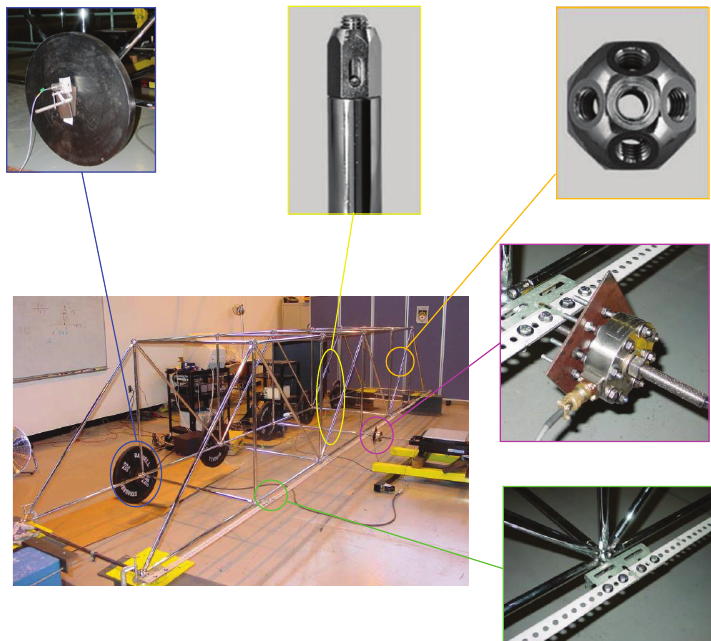
Figure 2: Configuration of the model steel bridge